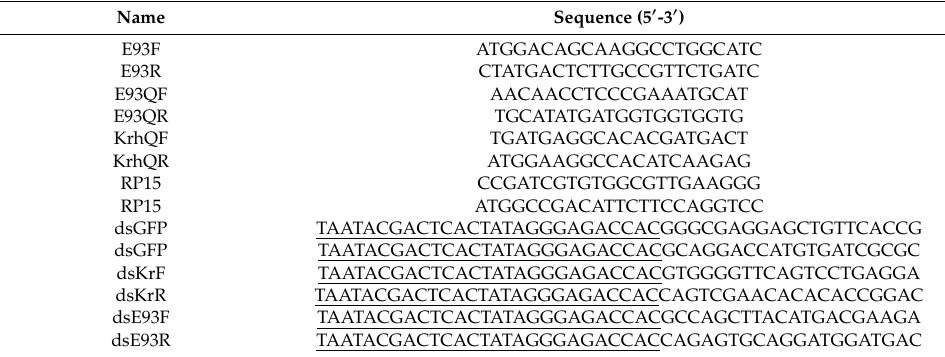
Table 1. Primers for cloning, QRT-PCR and dsRNA